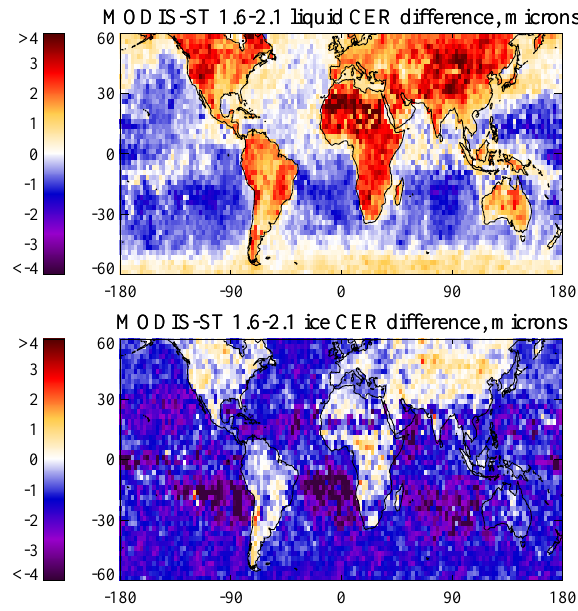
Fig. 16. Comparison between MODIS-ST cloud effective radius retrievals using 1.6µm and 2.1µm. The top shows the difference (1.6µm algorithm − 2.1µm algorithm) in retrievals for liquid water clouds, averaged to a 2.5 ◦ grid. The bottom panel shows the same, but for ice clouds. Grid cells without data are indicated in